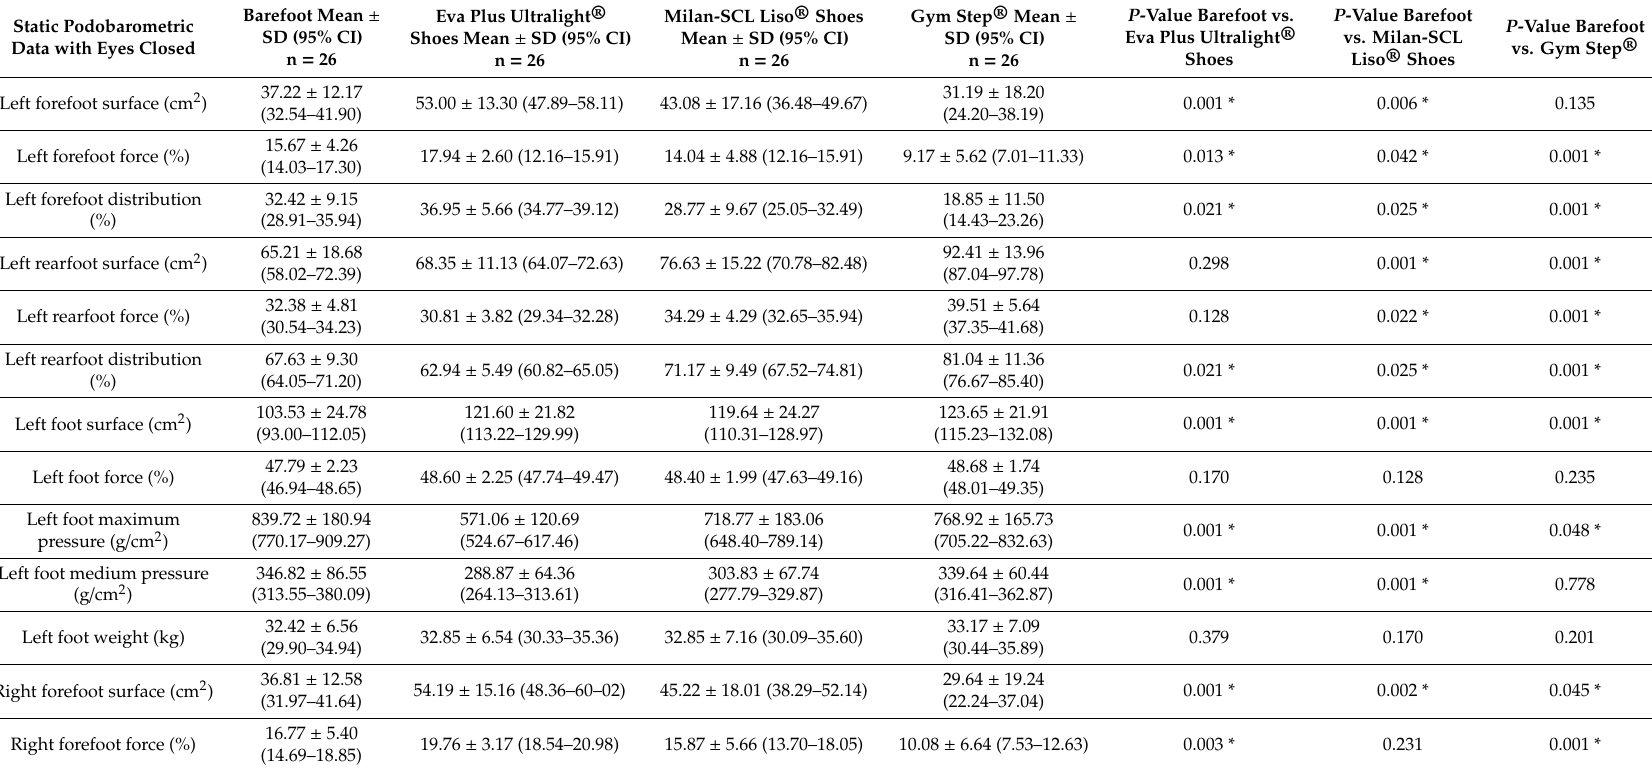
Table 8. Comparison of the static podobarometric data with eyes closed between